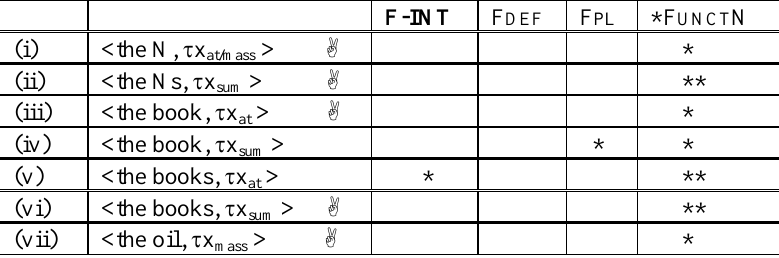
Tableau II: bidirectional OT tableau of singular/plural distribution in